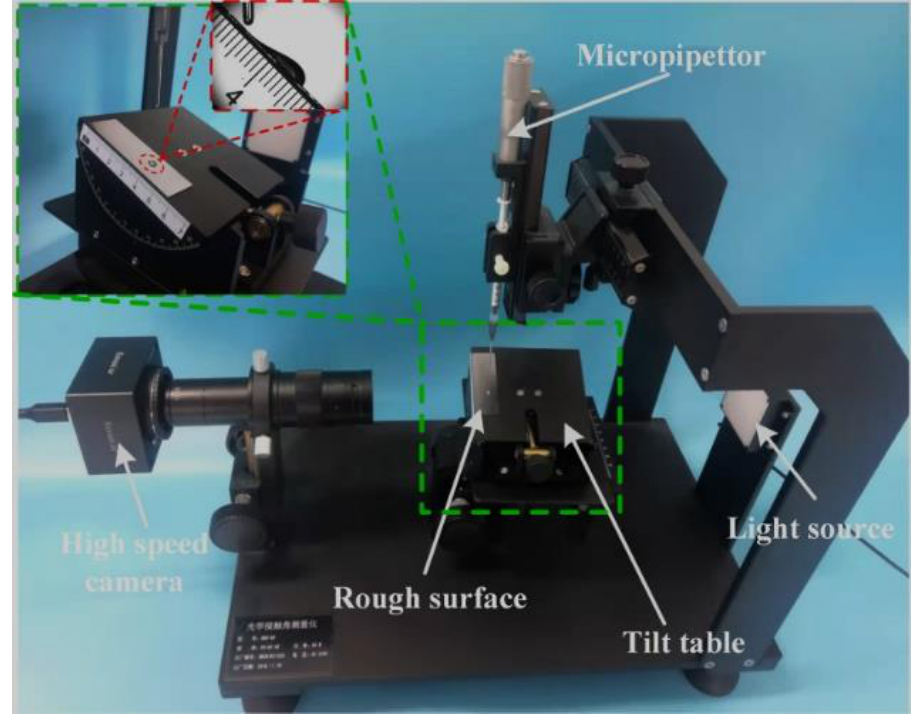
Figure 8. Schematic of the experimental apparatus.